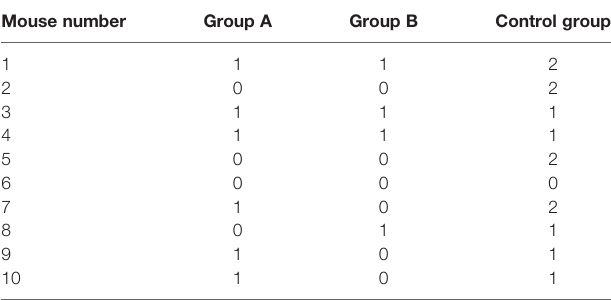
TABLE 1 | Stomach in fl ammation score.